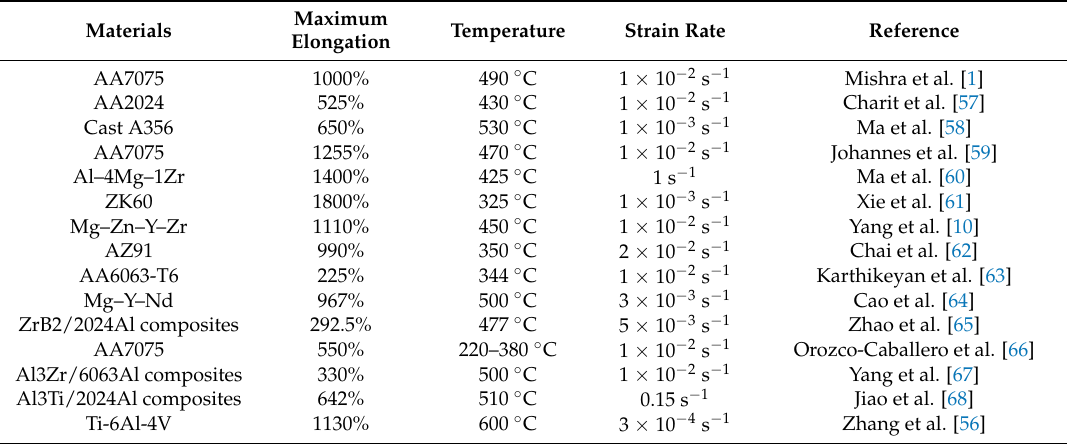
Table 1. Superplastic materials obtained via